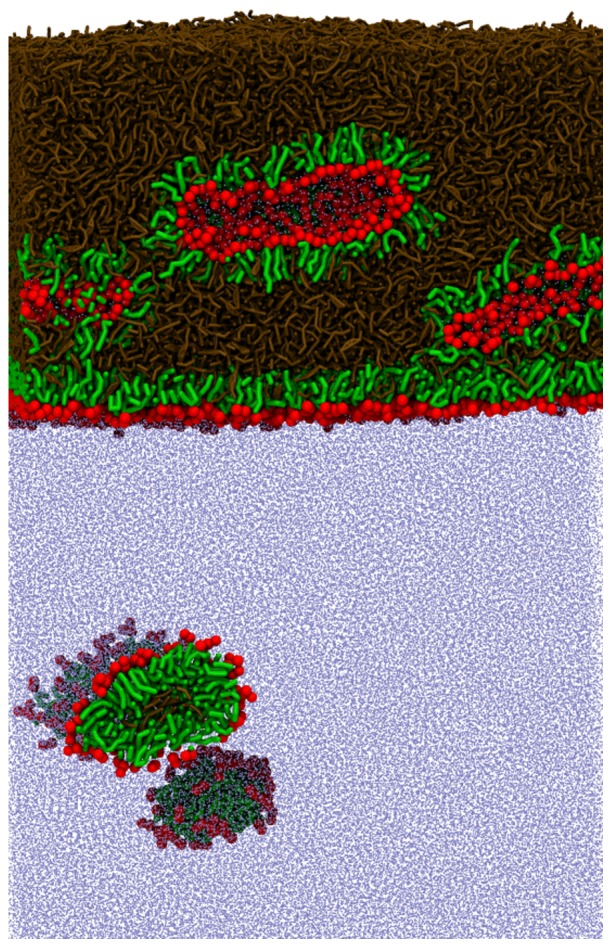
Simulation snapshot of the extended, laterally compressed system.The snapshot is taken at about 400-equilibrium compression trajectory of the sixteen-fold extended system. Inversed micelles are present in the non-polar lipid phase (both attached to and detached from the polar lipid layer. A micelle is present in the water phase. For color coding, see Fig.2A. Note that the picture represents a single simulation box, i.e., no lateral periodicity was applied. The lateral size of the box is of about 43 nm.